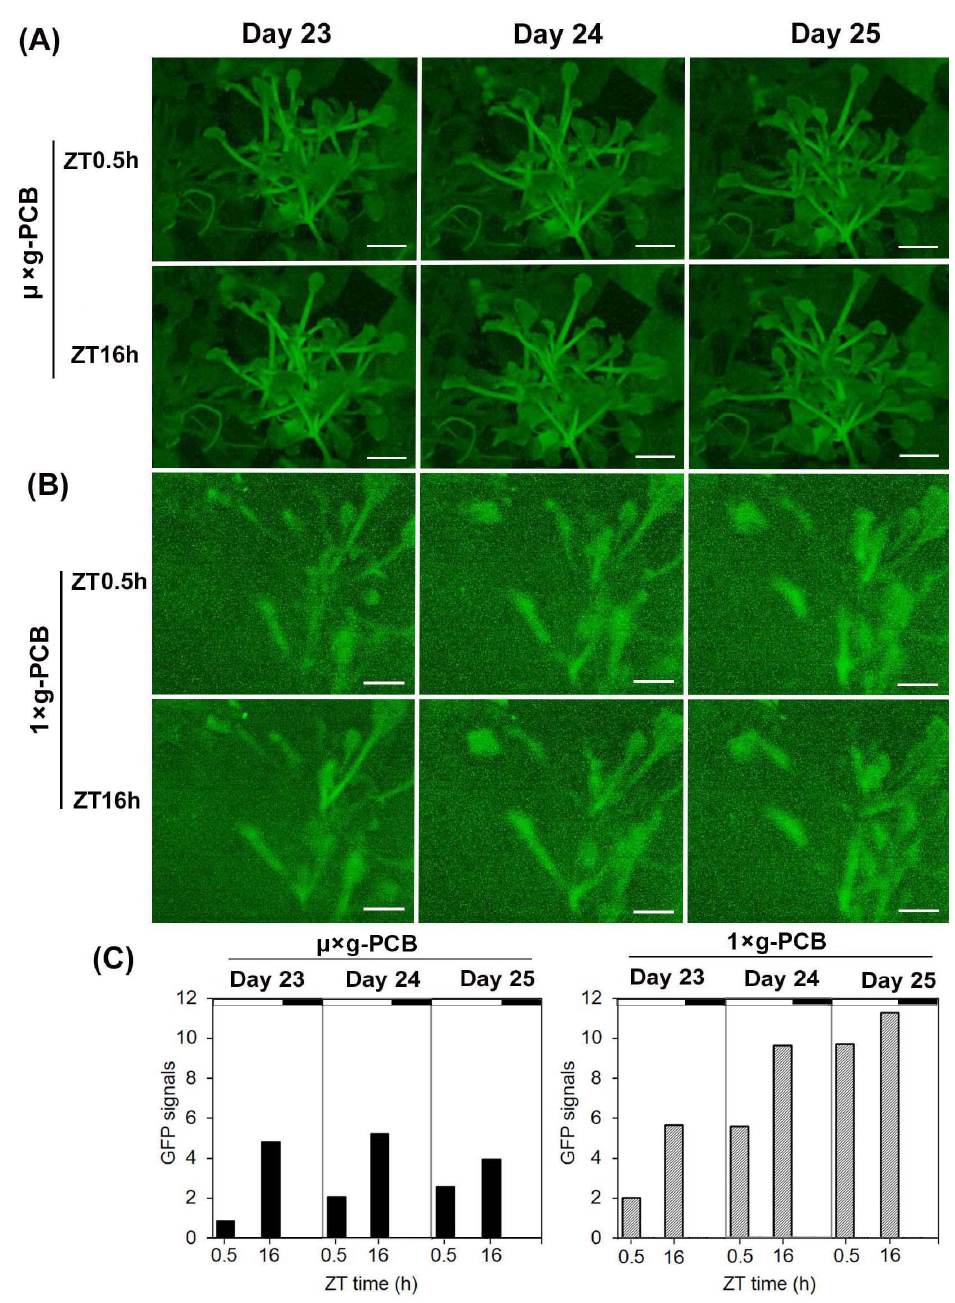
Figure 6. Time-course series of digital GFP images showing morning and evening GFP expression level under LD condition in space. ( A , B ) GFP expression profiles in pFT::GFP transgenic plants in morning (ZT0.5) and evening (ZT16) under the LD condition in space ( A ) and on ground at 23, 24, and 25 days after sowing (DAS). µ× g -PCB, Plants in PCB under microgravity in space. 1× g -PCB, Plants in PCB under the normal gravity (1× g ) on ground. Bars = 5 mm. ( C ) Quantification of GFP signal in the leaves of plants in space and on ground.